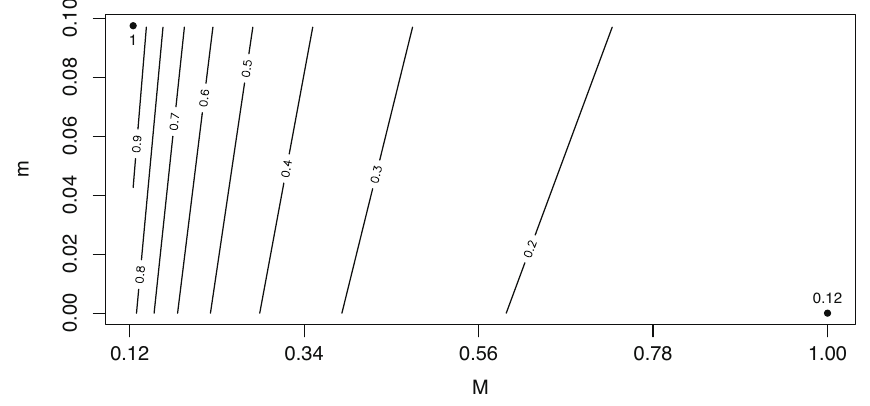
Figure 2: Contour plot of the lower bound LB as a function of the sensitivity parameters M and m in the feasible region M M 1 ≤ ≤ ∗